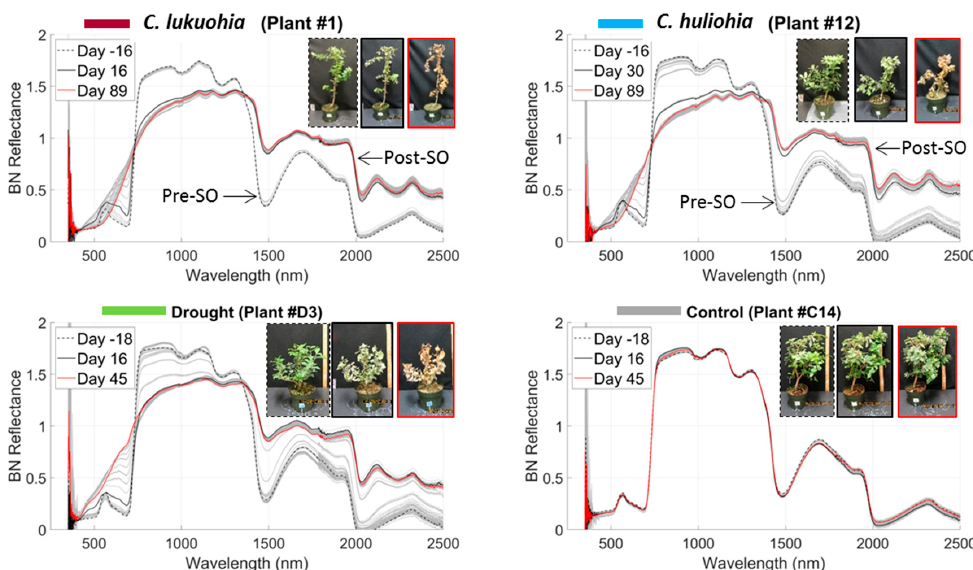
Figure 5. Example brightness normalized (BN) spectral time series data for four representative plants from the laboratory trials. Inset images are side-view RGB photos corresponding to pre-treatment (dashed line), stress onset (SO, solid black line), and late stress (red line) stages for treated plants, and corresponding time steps for the control plant. The numbers in the legend refer to days since treatment began, with negative values occurring pre-treatment.